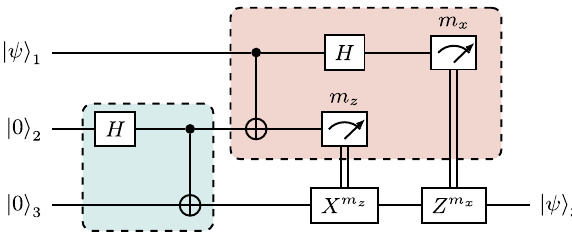
FIG. 12. Conventional quantum teleportation circuit. In the initial step a Bell pair is created with qubits two and three using the Hadamard and CNOT gates (blue box). Then a Bell measurement between qubits one and two is performed (red box), teleporting the initial state | ψ (cid:2) to system three up to Pauli corrections determined by the measurement result { m x , m z }